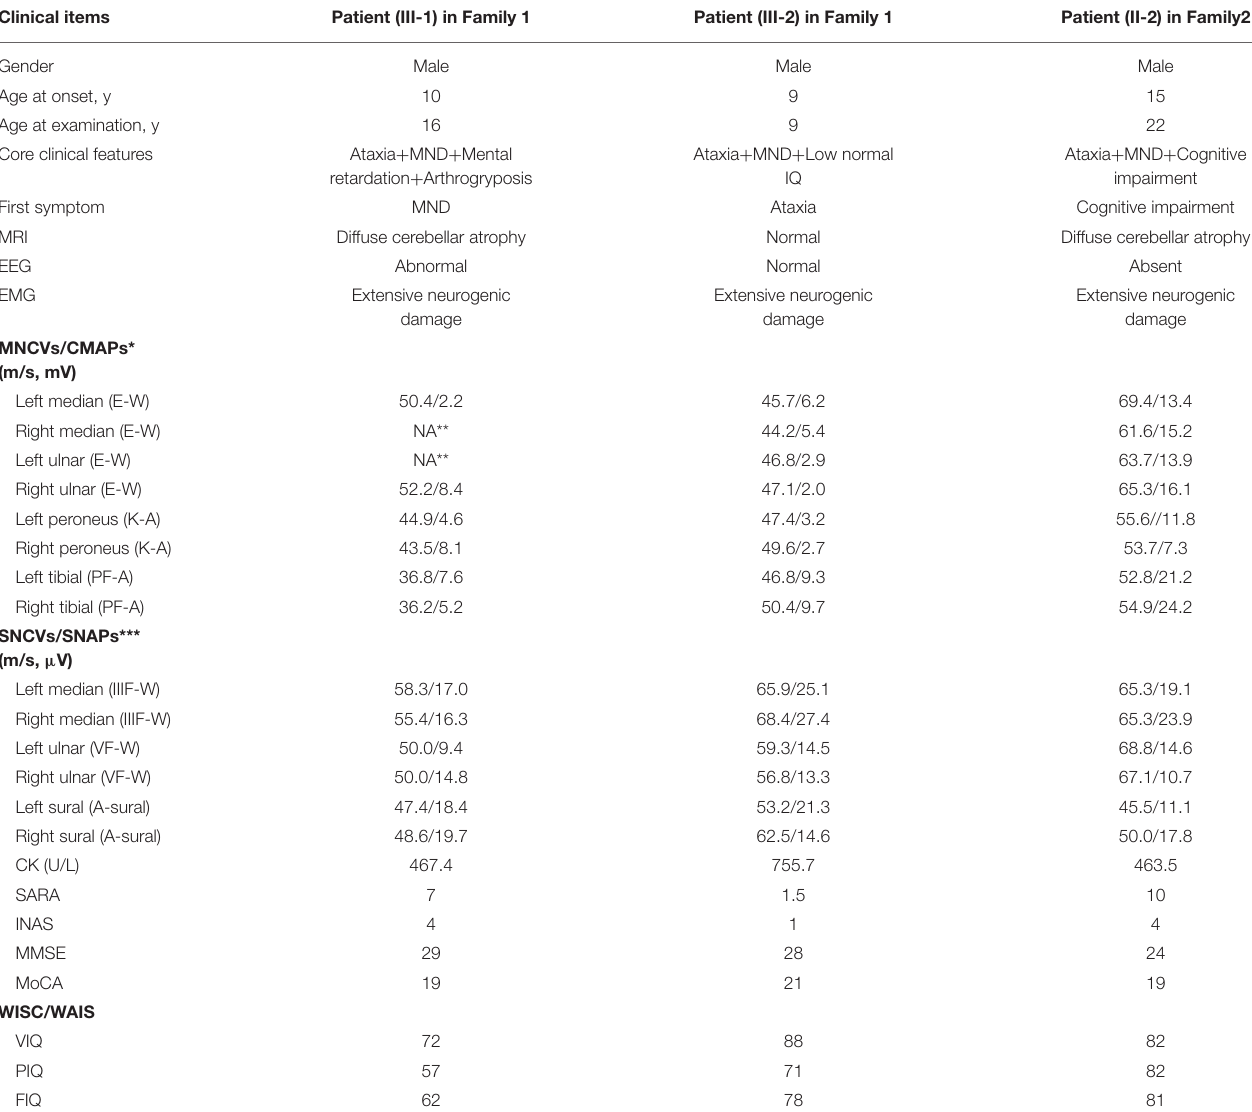
TABLE 1 | Clinical characteristics of SYNE1 ataxia patients in this